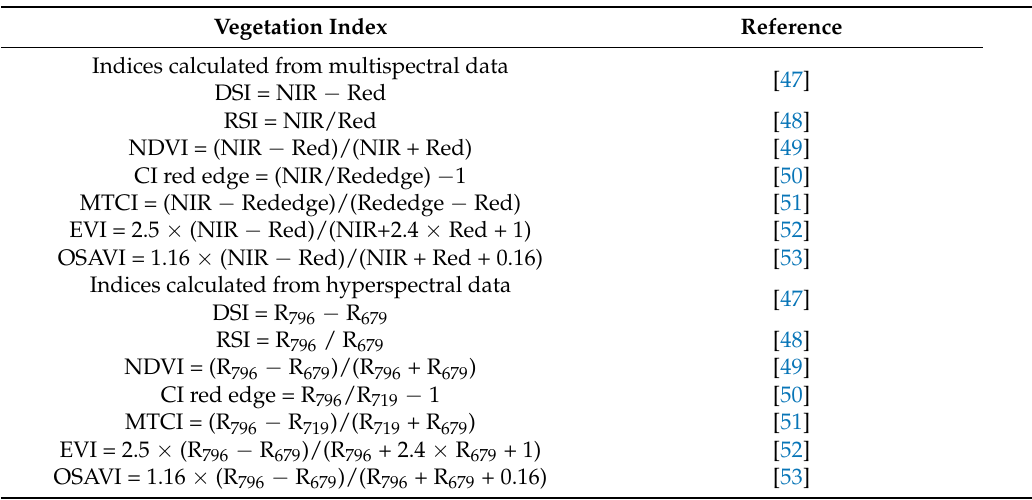
Table 2. Vegetation indices calculated from spectral data in this study. R 679 , R 796 and R 719 indicated the spectral bands at 679, 796 and 719 nm wavelength,